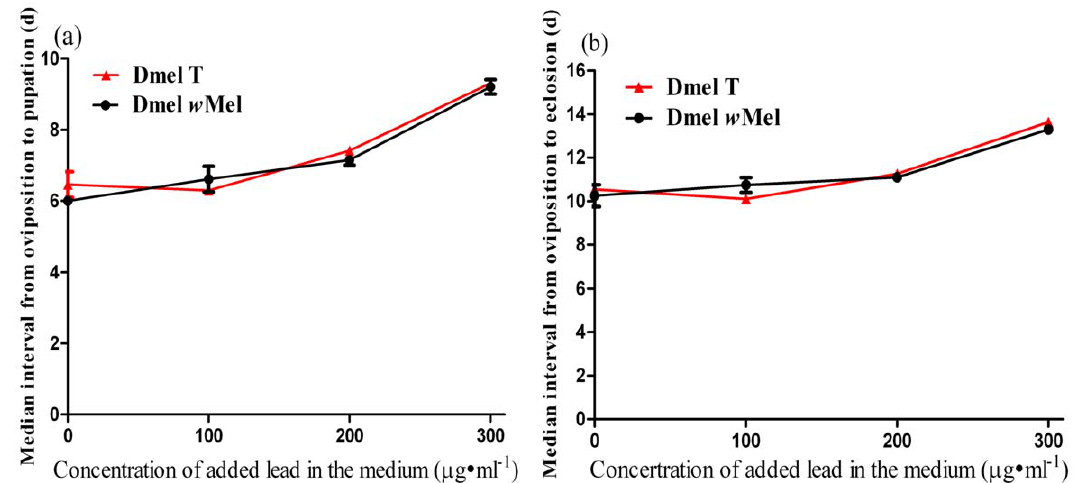
Figure 2. Effect of Wolbachia infection on the developmental time of Drosophila reared in Pb-contaminated food. ( a ) Median interval from oviposition to pupation. ( b ) Median interval from oviposition to eclosion. Bars=standard error.